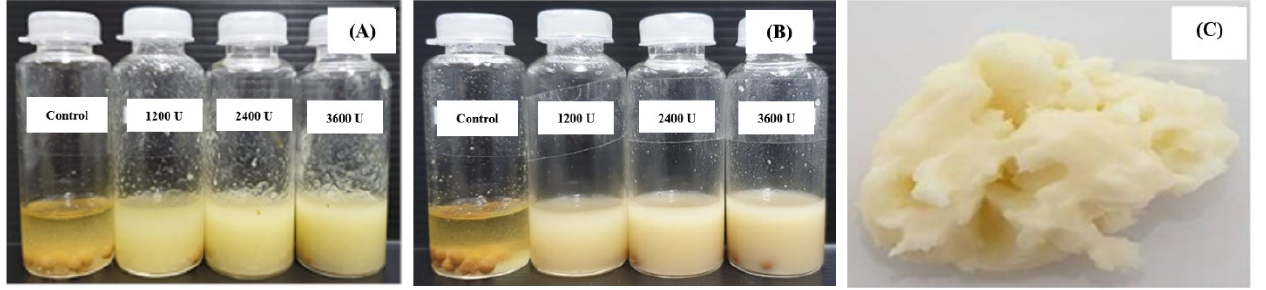
Figure 1. Appearance of glucose palm oleate green synthesis mixture; ( A ) before reaction started, ( B ) reaction mixture at 72 h and ( C ) the glucose palm oleate after drying. The response values as glucose palm oleate amounts derived from the 17 experimental designs of BBD are revealed in Table 5. The amount of glucose palm oleate in mmol per gram of ester product was calculated by comparing its UPLC peak area with the standard amounts of glucose palmate and glucose oleate. The conversion was obtained by comparing the amount of glucose palm oleate product to the initially used glucose quantity of 1 mmol. The RMS is an appropriate method for studying the effect of process variables and is extensively used for a variety of processes [27]. Table 5. Box–Behnken design with independent variables and response values.